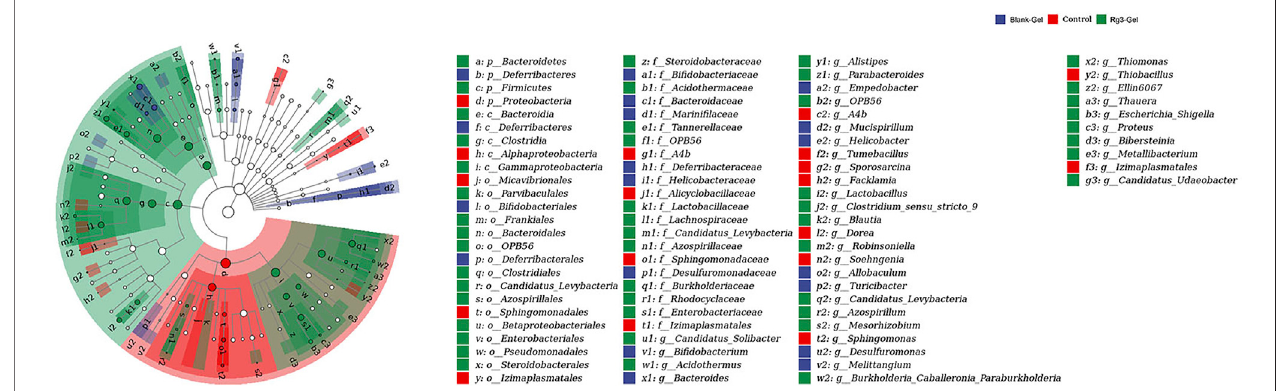
FIGURE 9 | LEfSe cladograms analysis of wound surface taxa at genus levels among the different